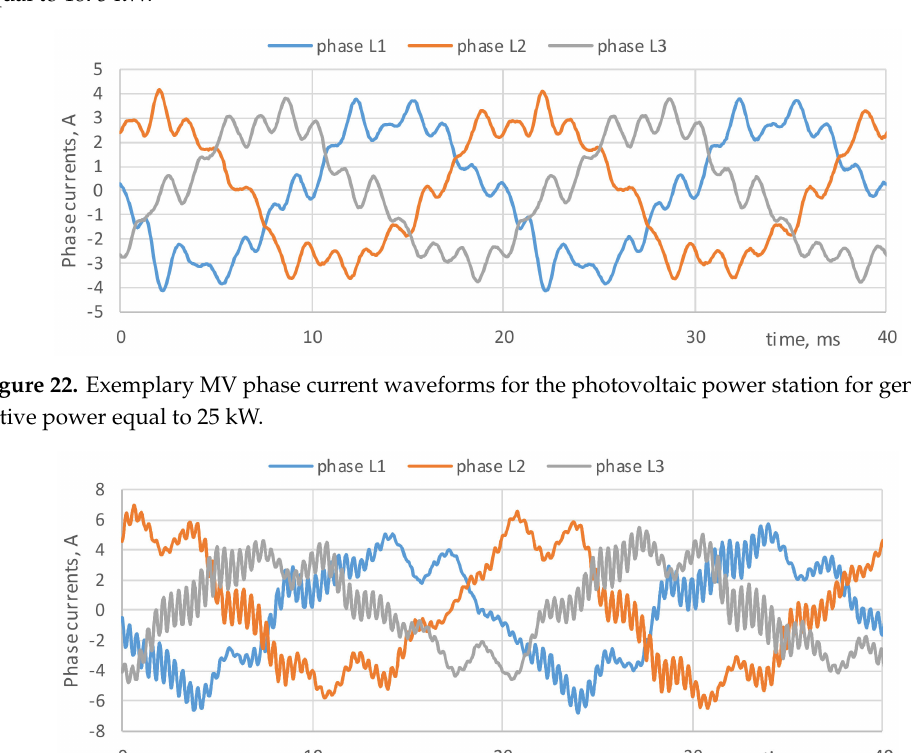
Figure 21. Exemplary MV phase current waveforms for the wind farm for generated active power equal to 1875 kW.